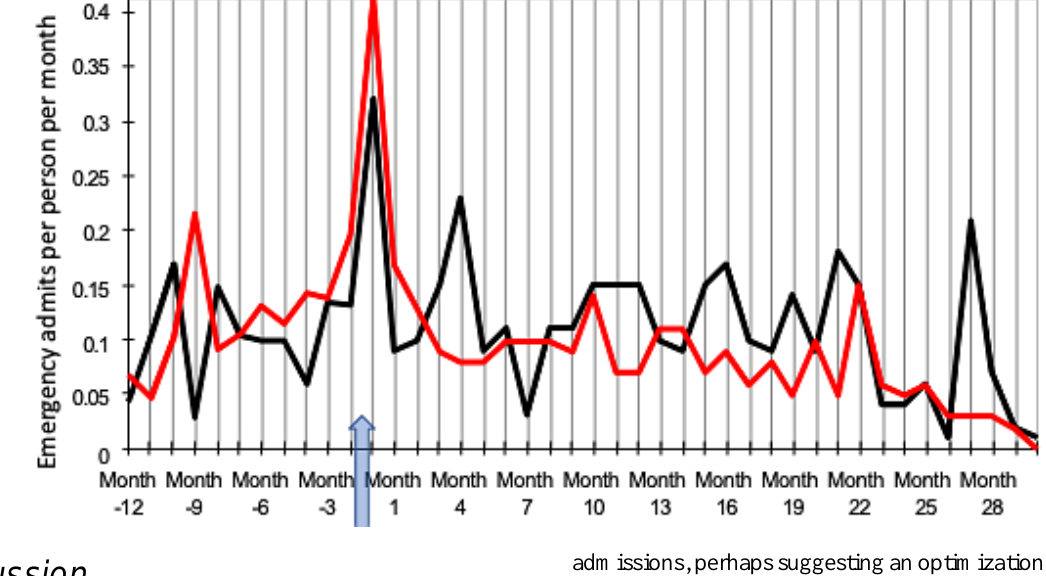
Figure 5. Rate of mean bed days per person per month in the usual care group (black) and intention-to-treat (red) 12 months prior to MonashWatch enrolment (indicated by the blue arrow) and for the subsequent 30 months. (Total admissions adjusted for numbers in each